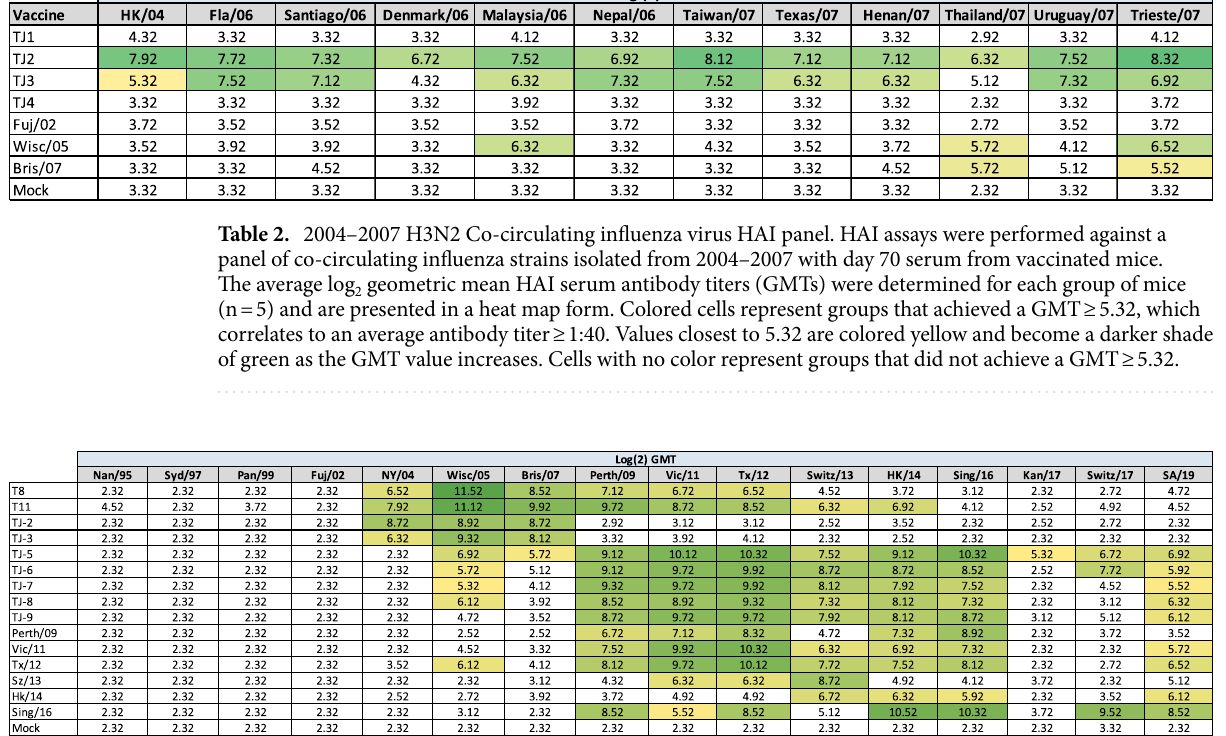
Table 3. Historical H3N2 influenza virus HAI panel. HAI assays were performed against a panel of historical influenza virus vaccine strains isolated from 1995 – 2016 with day 70 serum from vaccinated mice. The average log 2 geometric mean HAI serum antibody titers (GMTs) were determined for each group of mice (n = 5) and are presented in a heat map form. Colored cells represent groups that achieved a GMT ≥ 5.32, which correlates to an average antibody titer ≥ 1:40. Values closest to 5.32 are colored yellow and become a darker shade of green as the GMT value increases. Cells with no color represent groups that did not achieve a GMT ≥